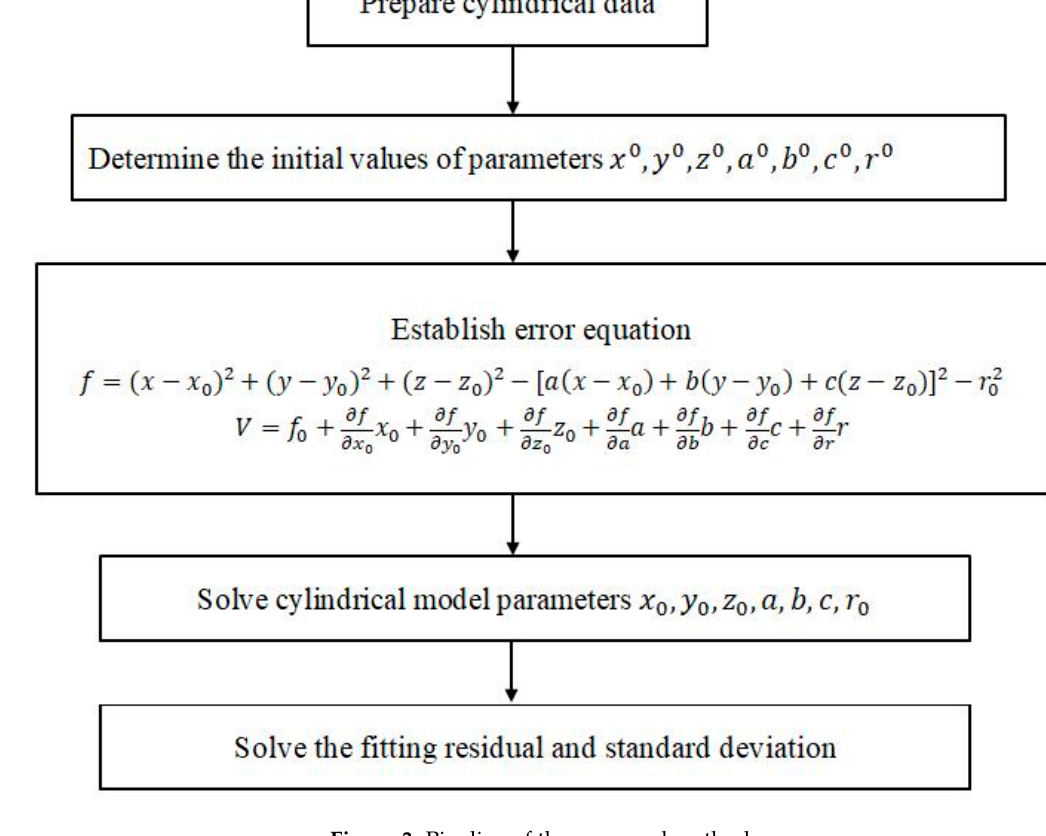
Figure 3. Pipeline of the proposed method.